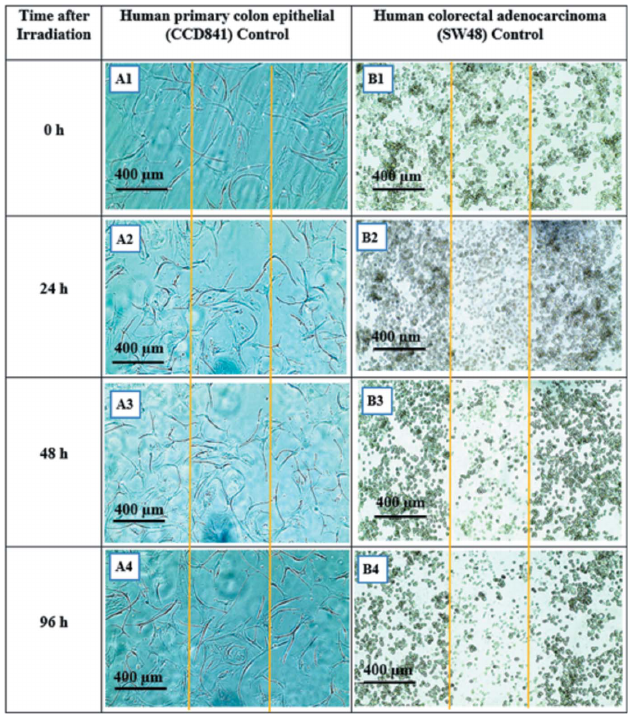
Figure 14 Human primary colon epithelial CCD841 and human colorectal adenocarcinoma SW48 monolayer 24 h after being exposed to 1000 Gy 90 kVp SBB (width 500 m m). Both cell types are control with no AuNPs treatment. The radiation fields boundaries are marked with orange lines. (A1) CCD841 immediately after exposure, (A2) 24 h, (A3) 48 h and (A4) 96 h after exposure. (B1) SW48 immediately after exposure, (B1) 24 h, (B2) 48 h and (B4) 96 h after exposure.